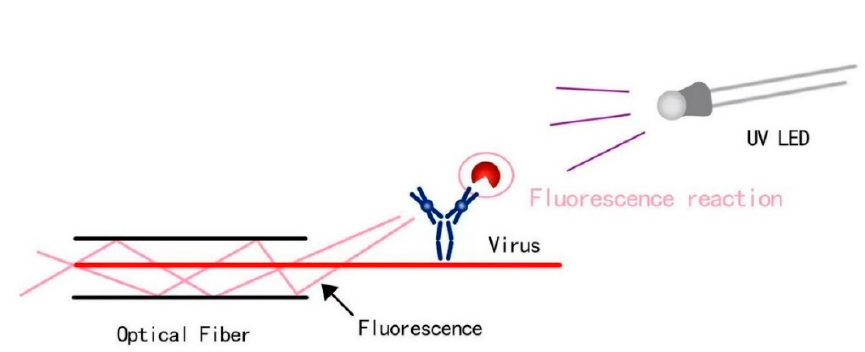
Figure 1. Detection principle in terms of fluorescence reaction and objects such as a